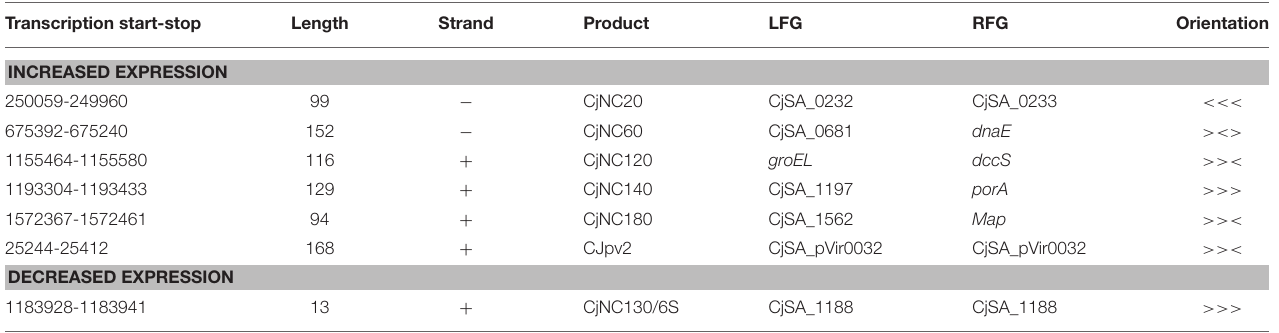
TABLE 5 | List of previously validated C. jejuni non-coding RNAs (Dugar et al., 2013) expressed and differentially regulated in our dataset with location, length, and orientation. Transcription start-stop Length